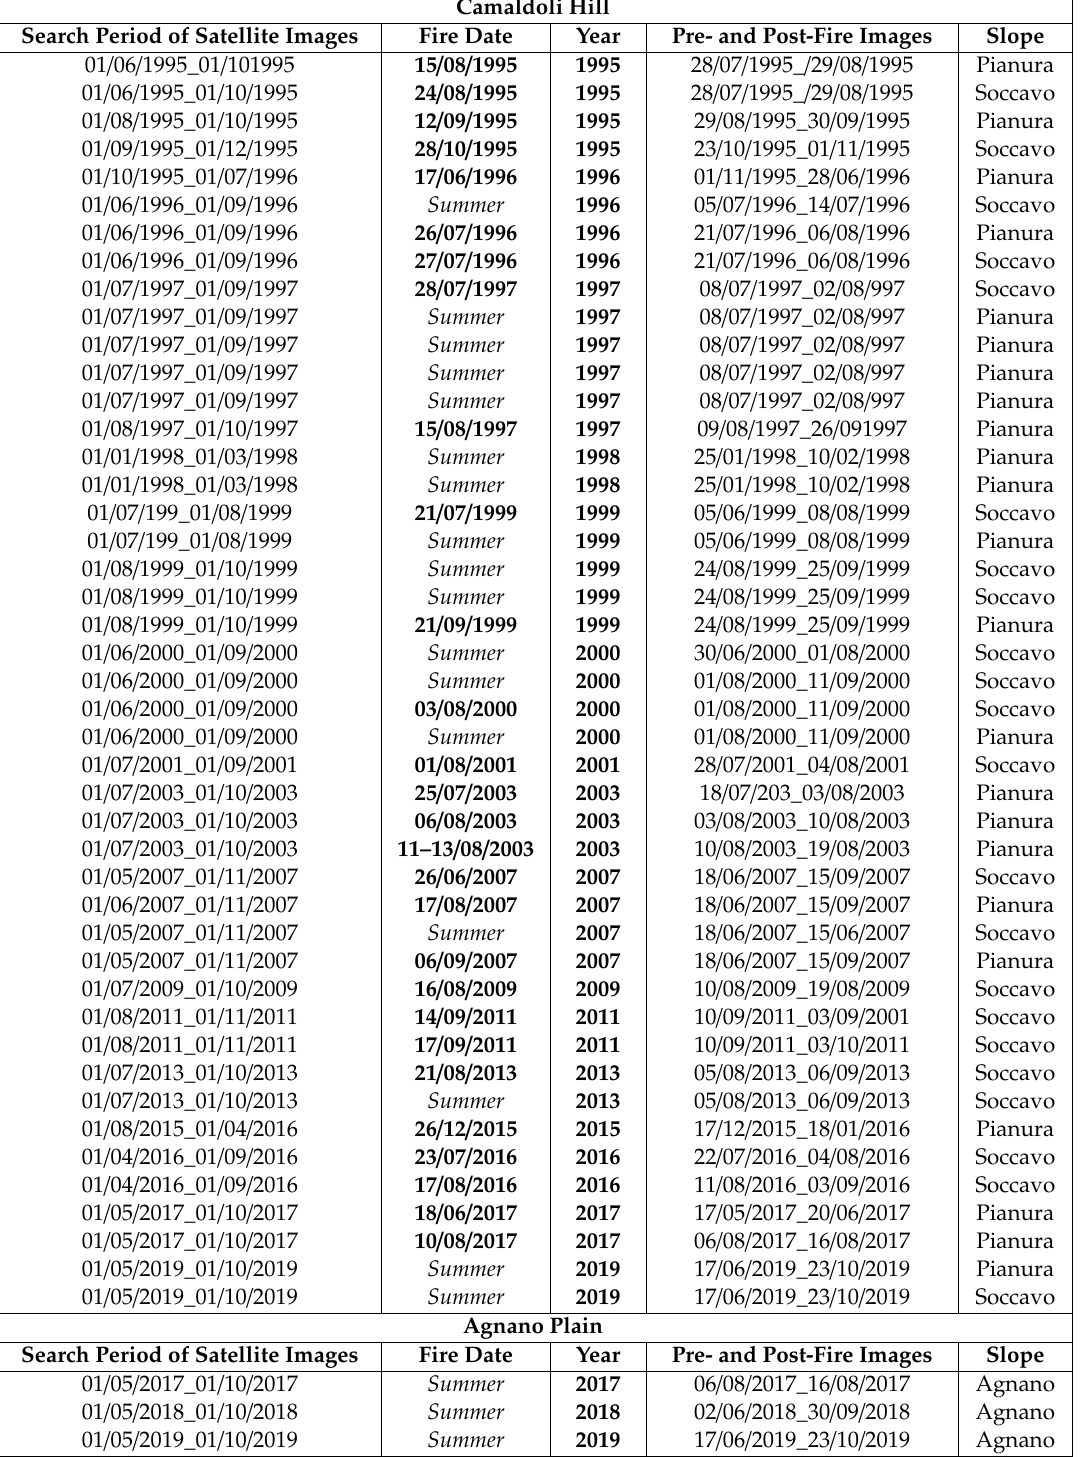
Table 4. Wildfires geodatabase from 1995 to 2019. Satellite imagery period = the data range within the satellite imagery was found for download; pre- and post-fire images = reference images (respectively pre- and post-fire) used for the digitization of burnt